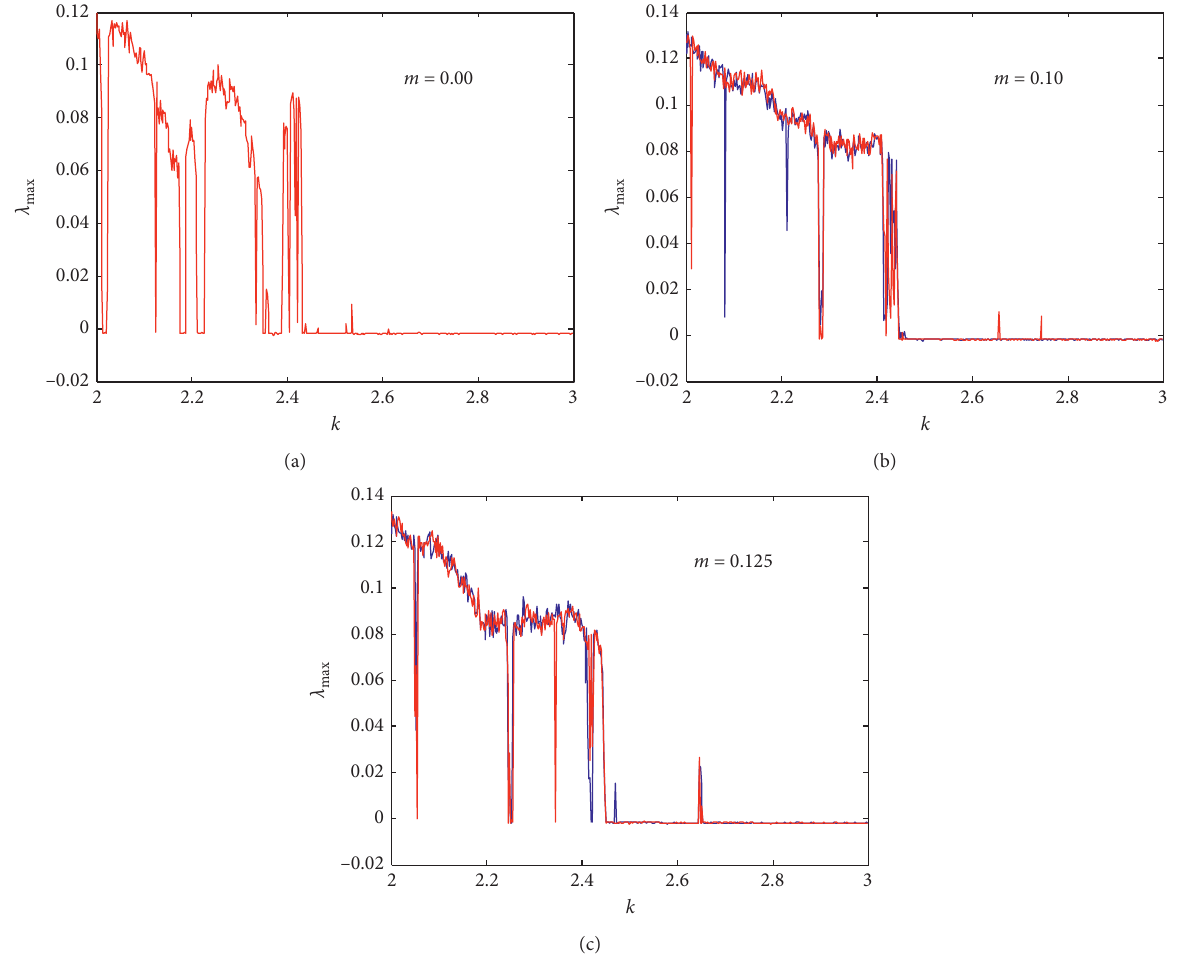
Figure 8: Diagrams of the maximum Lyapunov exponents corresponding to the bifurcation diagrams of Figure 7 showing the impact of the value of m on the symmetry of system (2) considering k as a control parameter.